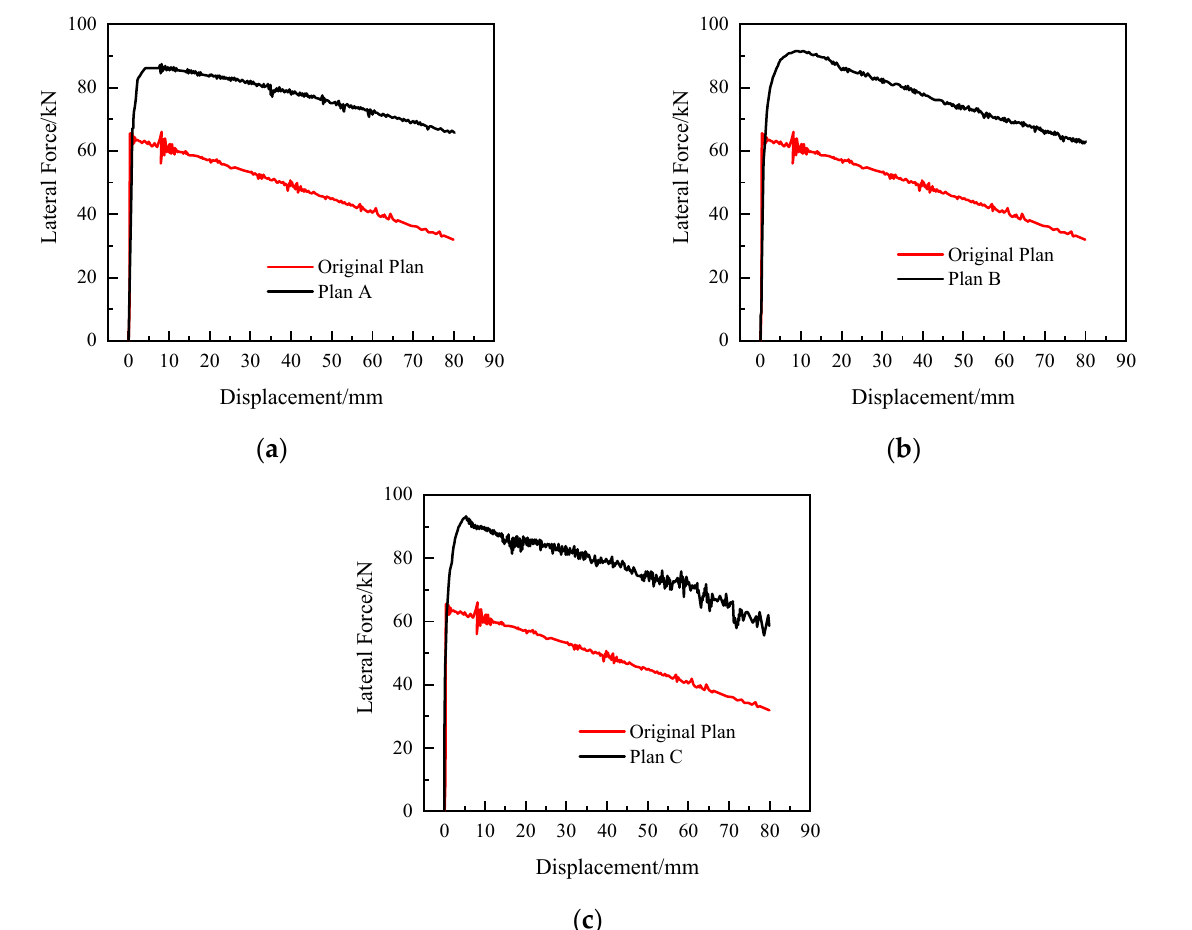
Figure 15. Comparison of the load–deflection curve of each scheme. ( a ) Plan A. ( b ) Plan B. ( c ) Plan C.